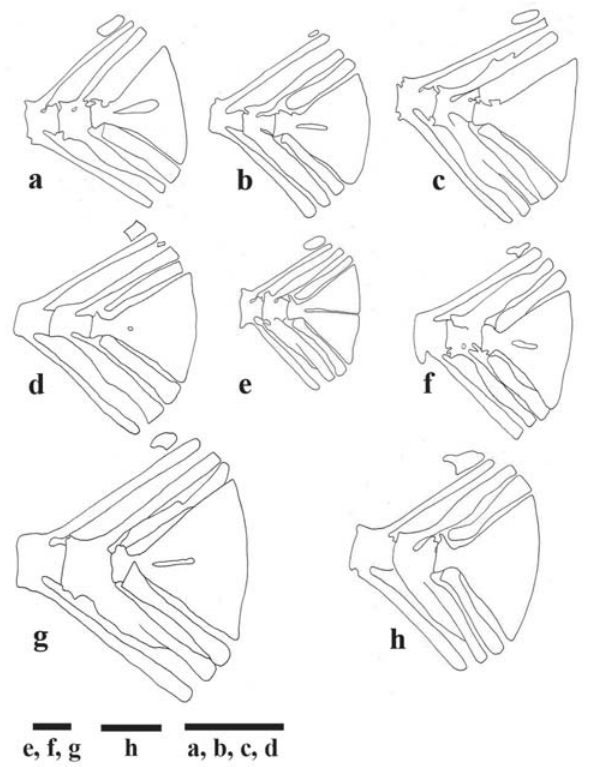
Fig. 7. Lateral view of caudal-fin skeleton in: a ) Phalloceros caudimaculatus , MCP 4052; b ) Heterandria formosa ,